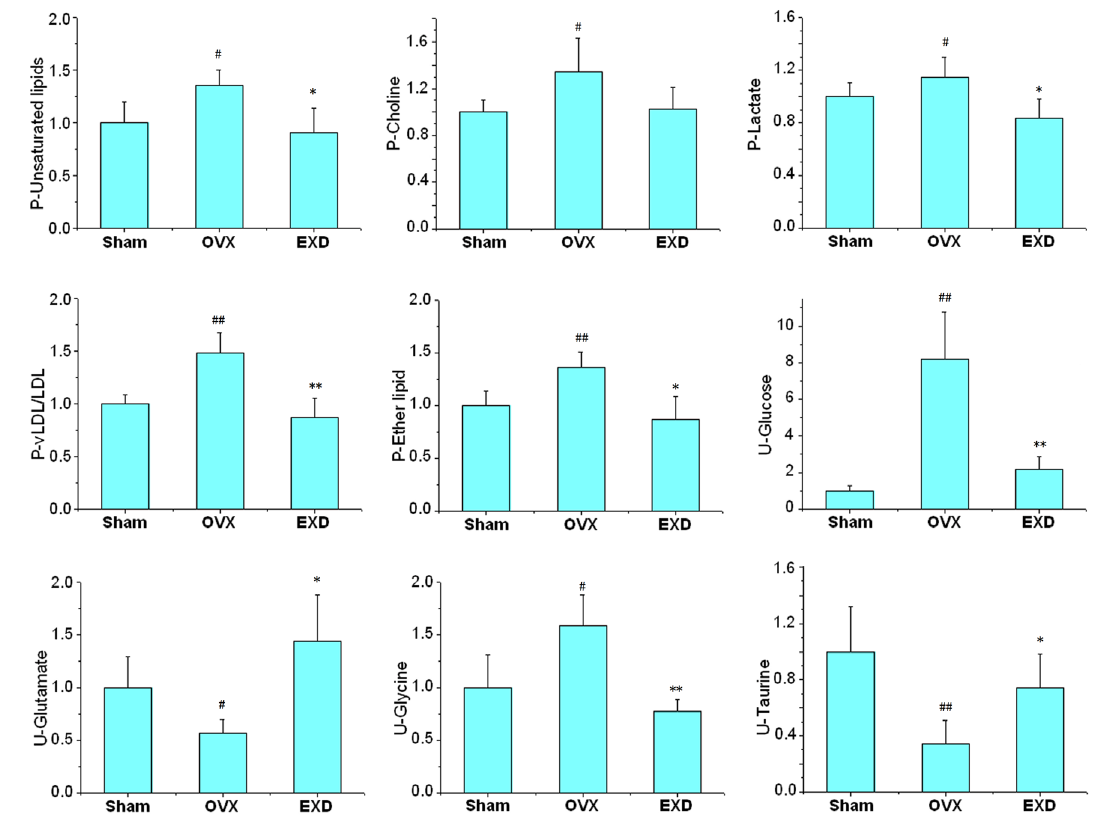
Figure 4. The relative levels of nine significantly altered metabolites in the rats of sham, OVX and EXD treatment groups. The percentage has been calculated with the formula: Contents in groups /content in control group × 100%. P—plasma, U—urine. ## P <